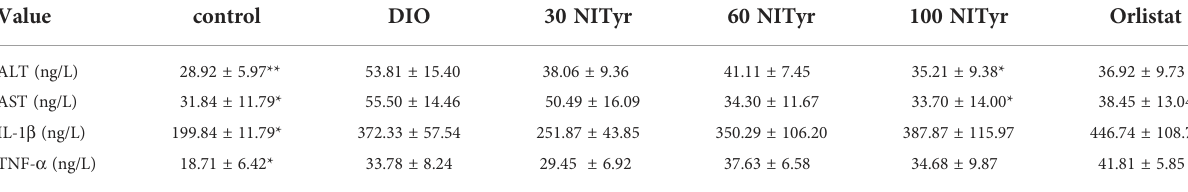
TABLE 3 Analysis of liver injury and in fl ammation indexes in serum in mice after 4-week administration of drugs.